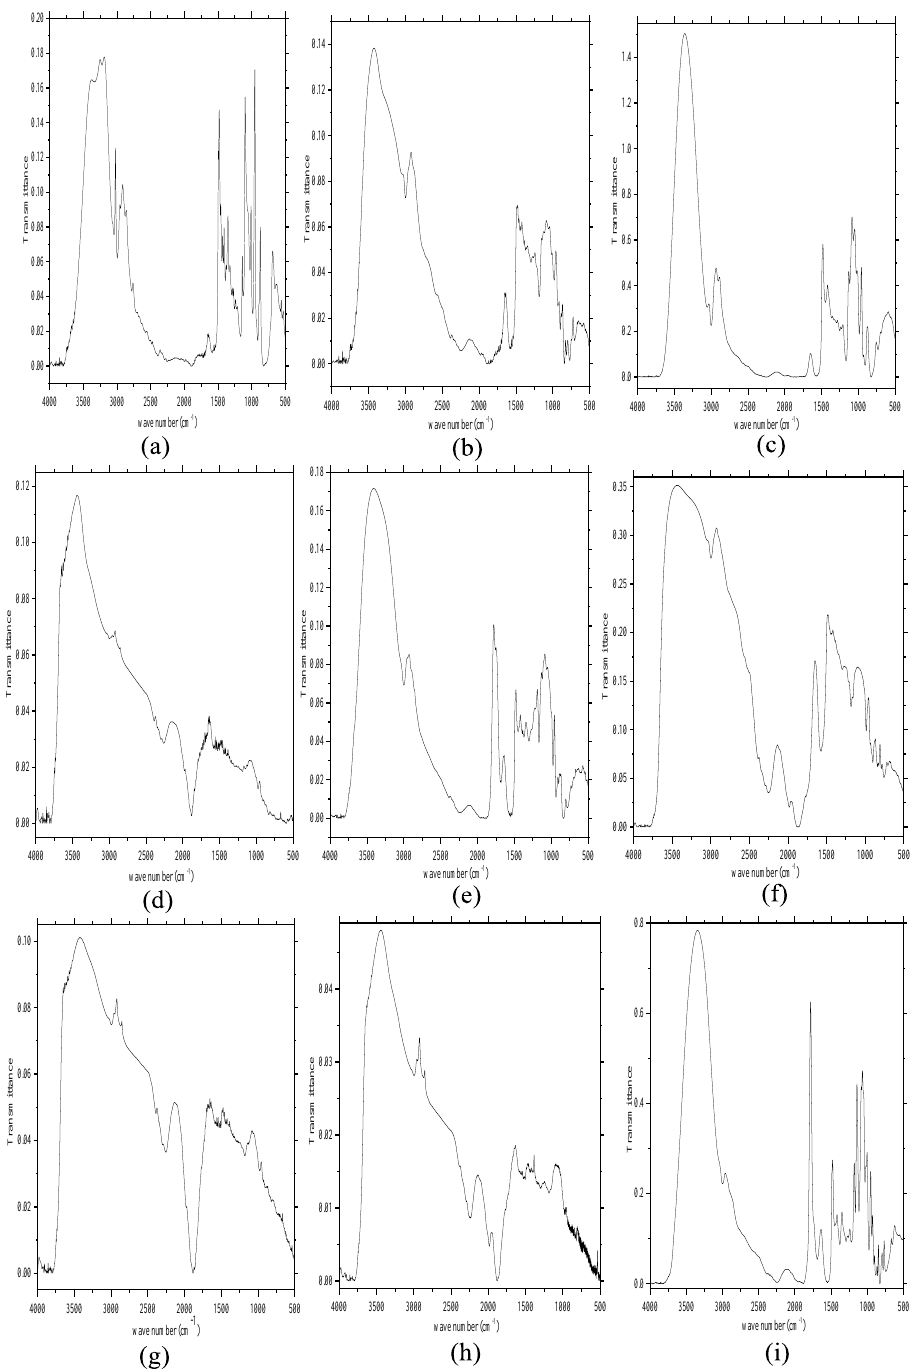
Figure 1. FT-IR spectra of ChCl-based NADESs. a : ChCl – Ery, b : ChCl – Rib, c : ChCl – Xyl, d : ChCl –